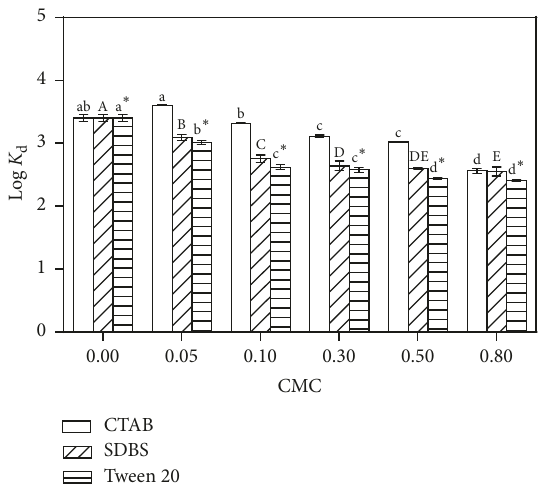
Figure 8: Effects of the surfactants on adsorption of BPA on BC300 under different surfactant concentrations. The bars indicate the standard error of triplicates, and different letters indicate signifi- cant difference ( p < 0 .